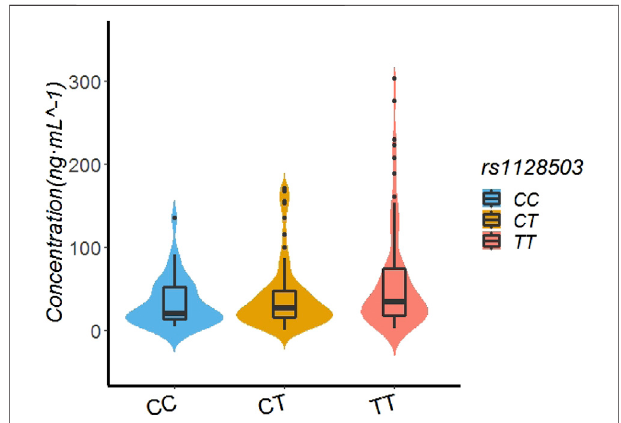
FIGURE 2 | Effect of SNP rs1128503 on Rivaroxaban dose of 155 recipients.